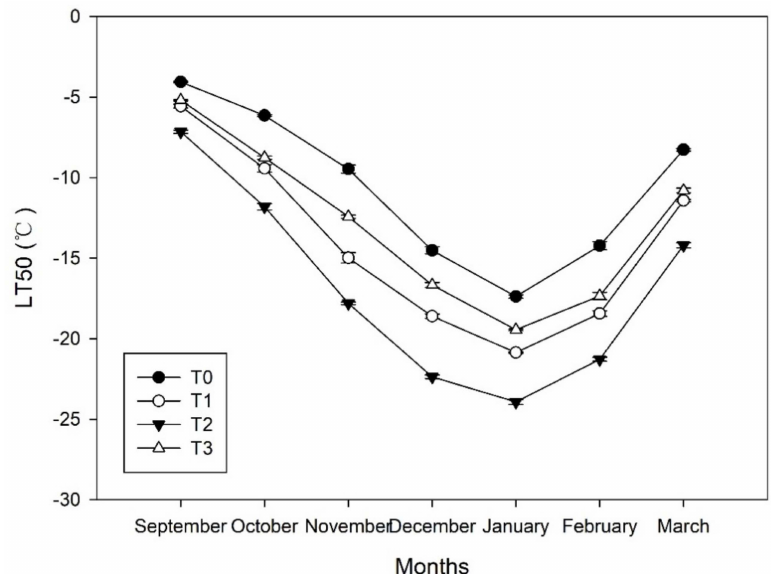
Figure 6. Dynamics of the freezing tolerance of shoots in Magnolia wufengensis under ethephon (ETH) treatments.